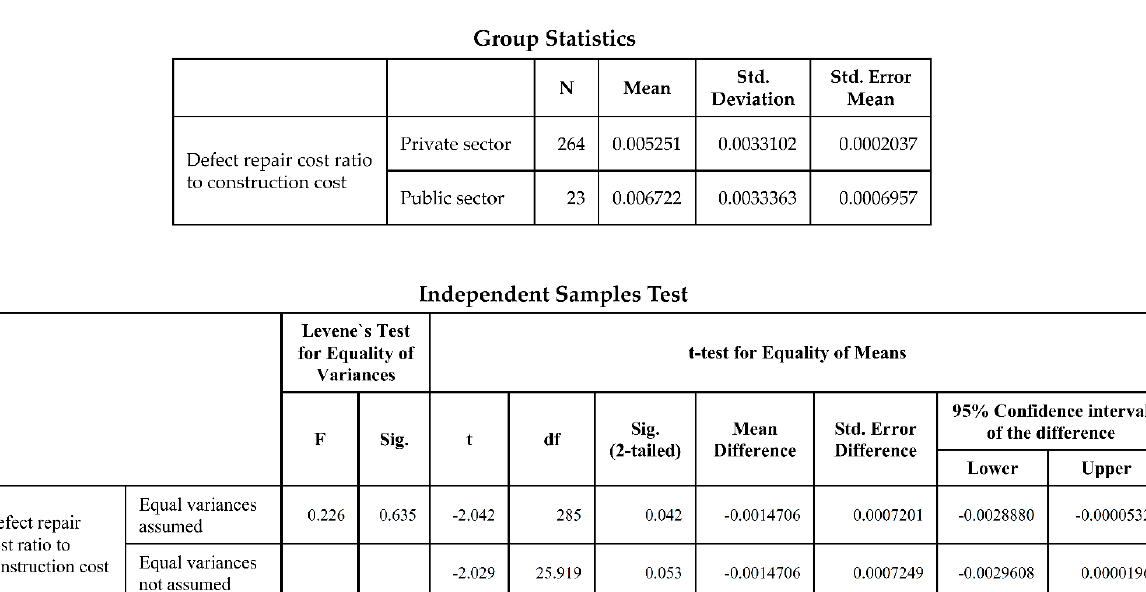
Figure B1. T-test result of project entities.